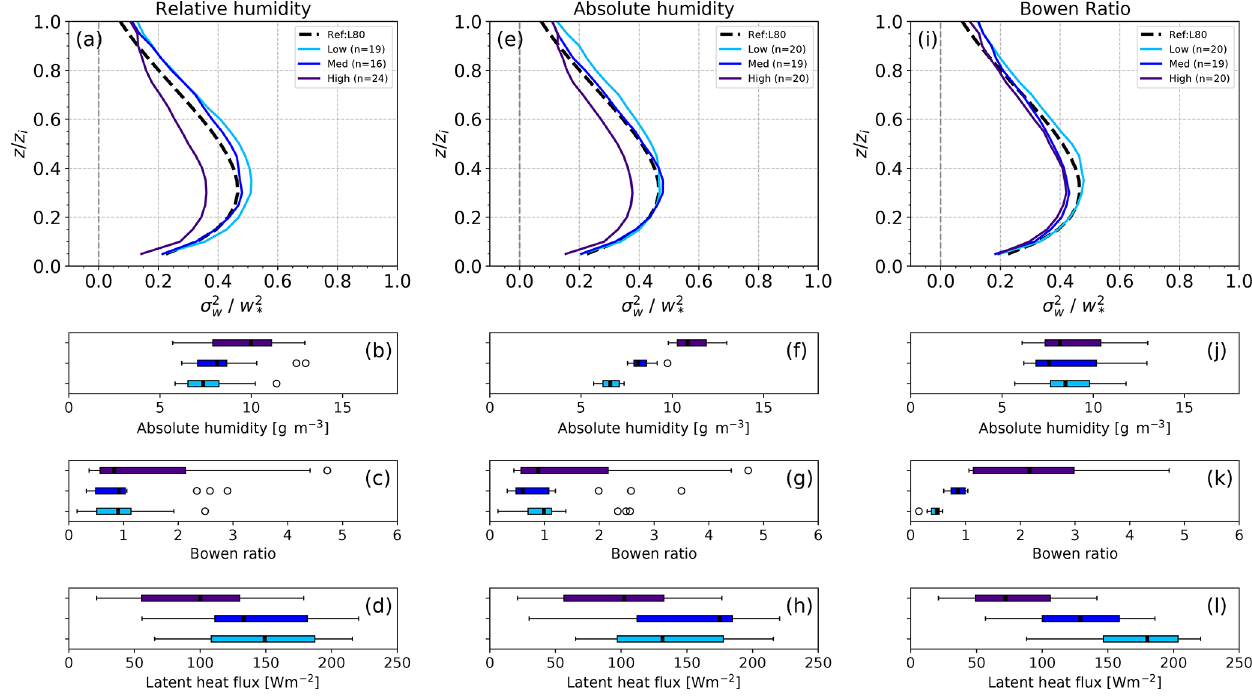
Figure 12. Similar as in Fig. 11 but for (a) relative humidity, (e) absolute humidity and (i) Bowen ratio.